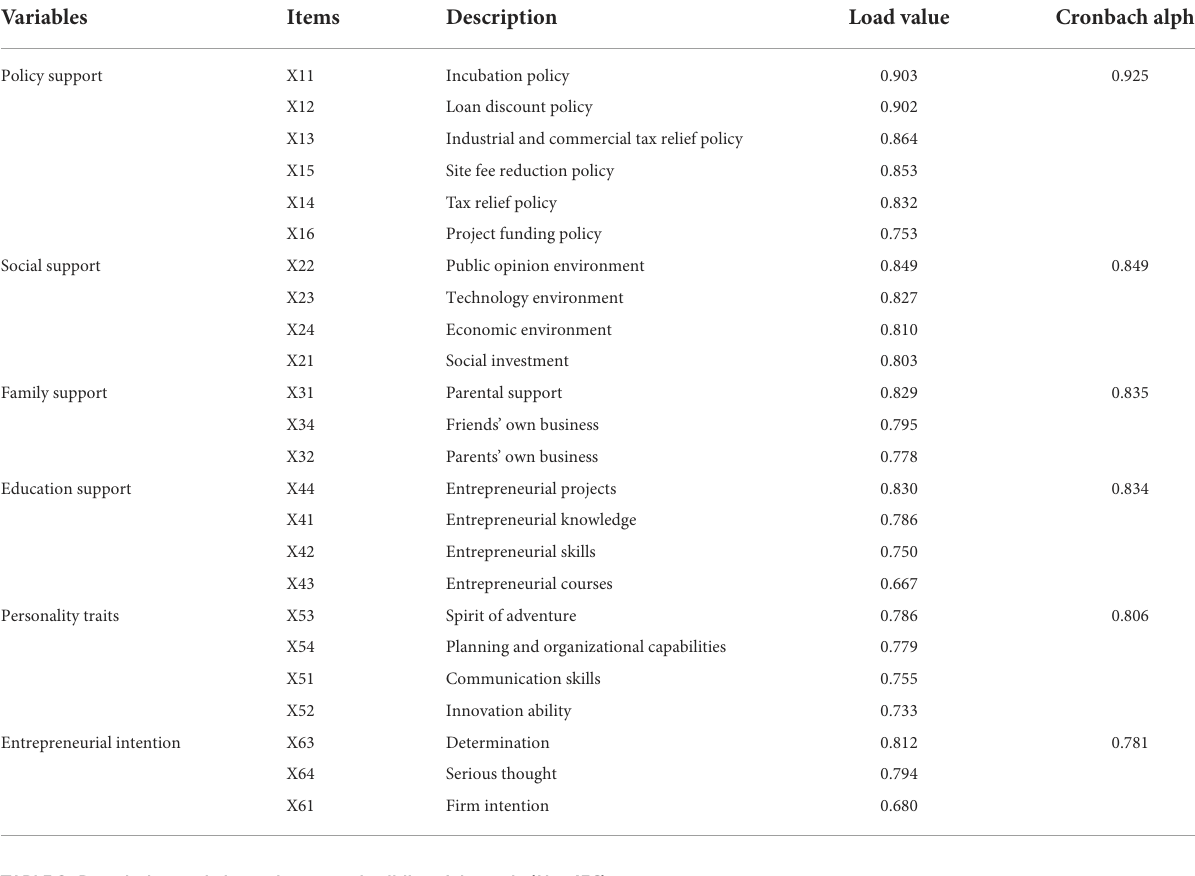
TABLE 1 Rotated component matrix ( N = 436).